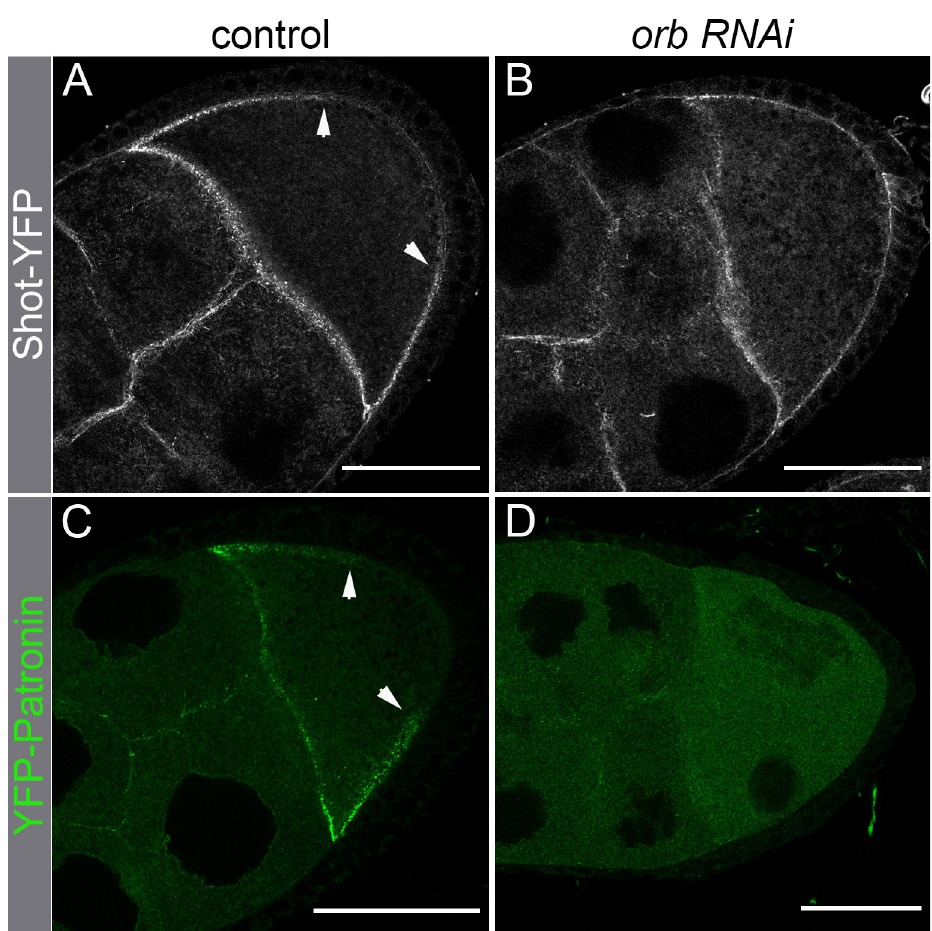
Fig 8. Shot and Patronin cortical association is disrupted when orb activity is compromised. orb RNAi ( 64002 ) was expressed during mid-stages of oogenesis using the maternal α -tubulin Gal4 ( 7062 ) driver in flies carrying a BAC transgene with shot tagged with a C-terminal YFP, or a maternally expressed YFP-patronin transgene[21]. (A, C) In maternal α -tubulin Gal4 control stage 9 egg chambers, Shot-YFP and YFP-Patronin associate with the anterior and anterior lateral cortical actin network. As indicate by the arrows, only very low levels of these proteins localize to the posterior cortex. (B,D) When orb activity is compromised by RNAi knockdown, the association of Shot-YFP and YFP-Patronin with the anterior and anterior-lateral cortex is disrupted. Scale bars are 50